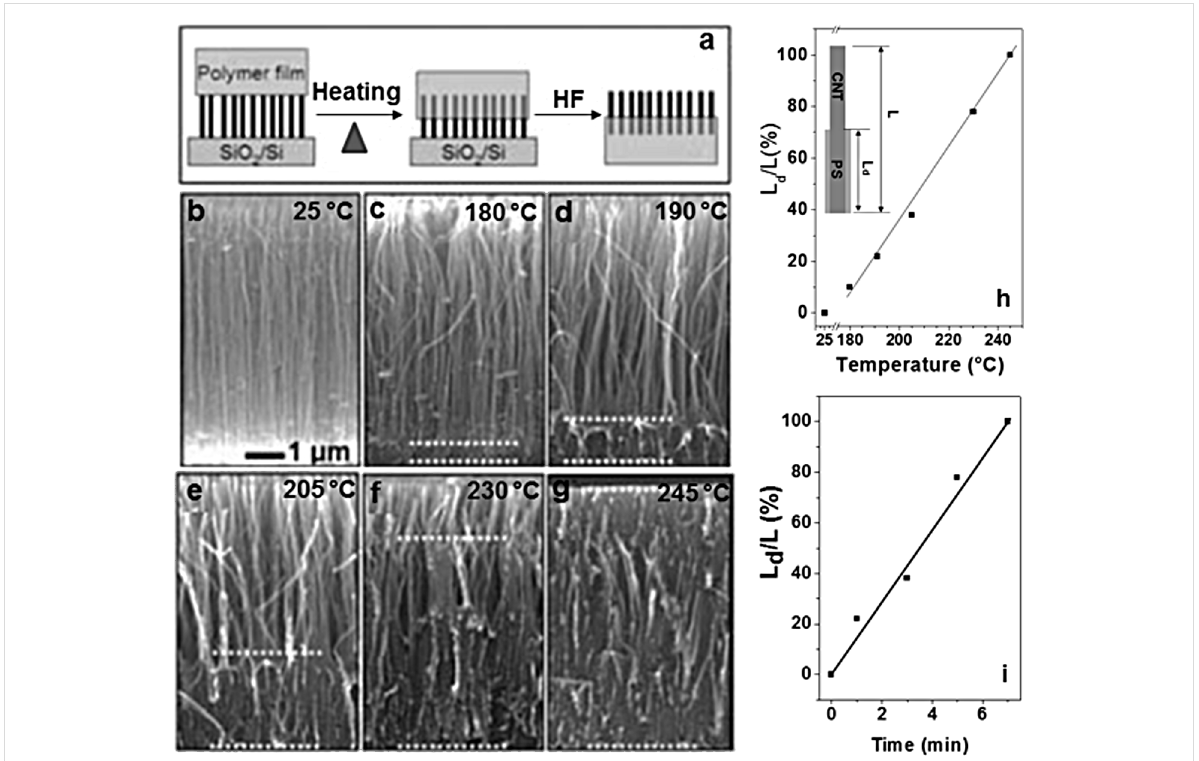
Figure 19: (a) Schematic representation of the VA-CNTs embedded into a polymer matrix by thermal infiltration of the melted polymer into the nanotube forest; (b)–(g) SEM images of (b) the pristine VA-CNT array and (c)–(g) the VA-CNT array after being embedded into PS films by heating at different temperatures for 1 min. The gaps between the dashed lines crossing the polymer coated regions show the approximate embedment length for each of the PS-embedded VA-CNTs; (h) and (i) temperature and time dependence of the embedment length for VA-CNTs embedded into the PS matrix ( L : nanotube length ( ≈ 6 μ m), L d : embedment length, which was estimated from the distance between the two dashed lines in each of the images shown in (c)–(g). Adapted with permission from [144]. Copyright 2007 Royal Society of